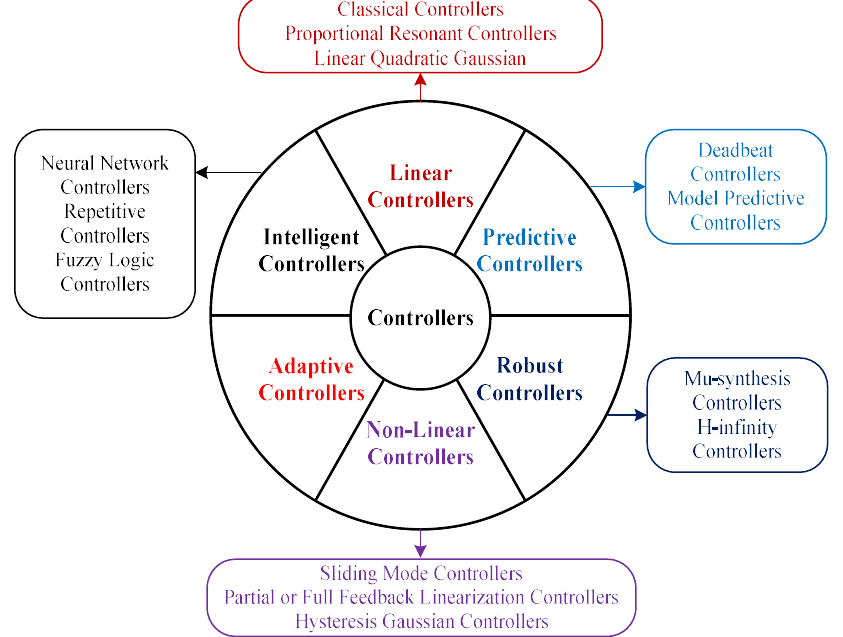
Figure 10. Different types of control strategies [144]. Figure 10. Di ff erent types of control strategies